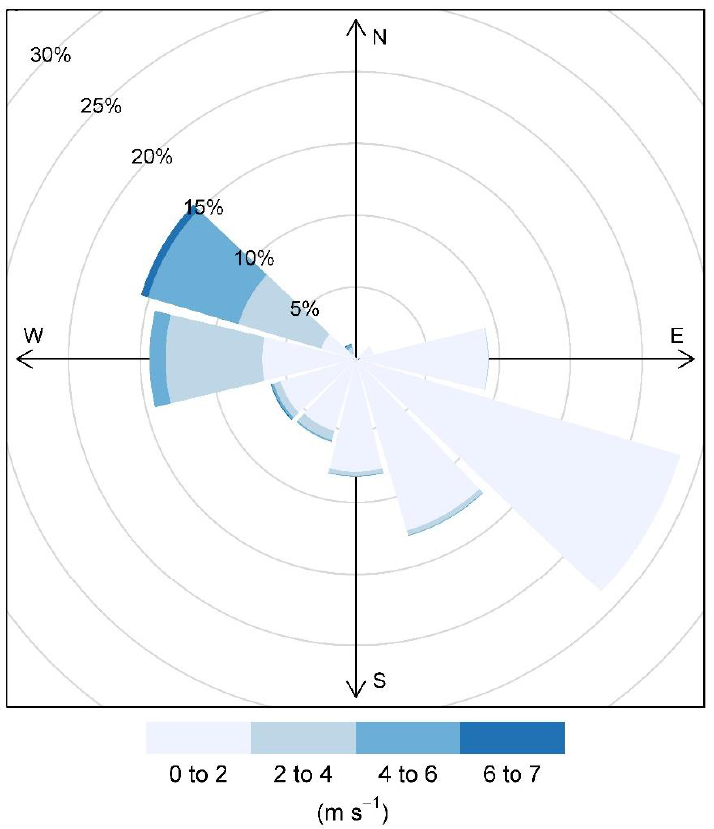
Figure 2. Wind rose for the full study period: 14 April 2016, to 6 July 2016.